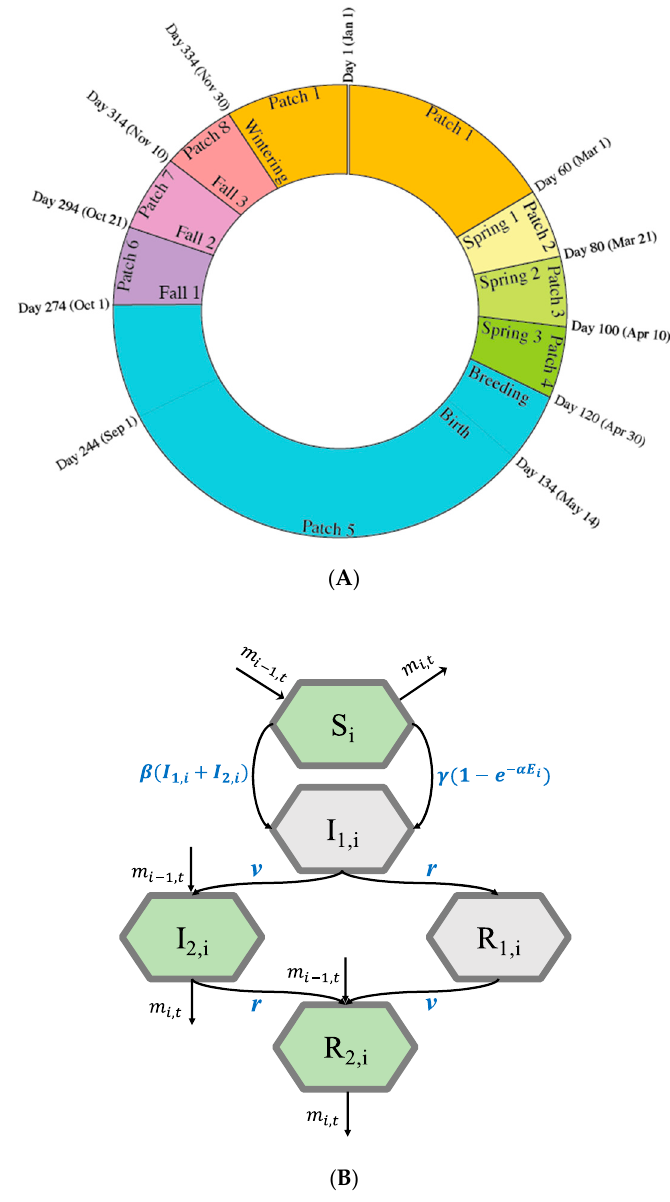
Figure 1. ( A ) Annual migration schedule of the simulated migratory bird populations. The model starts on day 1 and ends on day 365 of a year. The wintering season is from day 334 of the preceding year to day 60 of the next year (Patch 1); ( B ) Model structure showing the movement of birds in between compartments within one flock at Patch i [26]. The five compartments are: Susceptible (S), infected and unable to migrate ( I 1 ), infected and able to migrate ( I 2 ), recovered and unable to migrate ( R 1 ), or recovered and able to migrate ( R 2 ). Migration is only possible for birds in compartments S, I 2 , and R 2 .